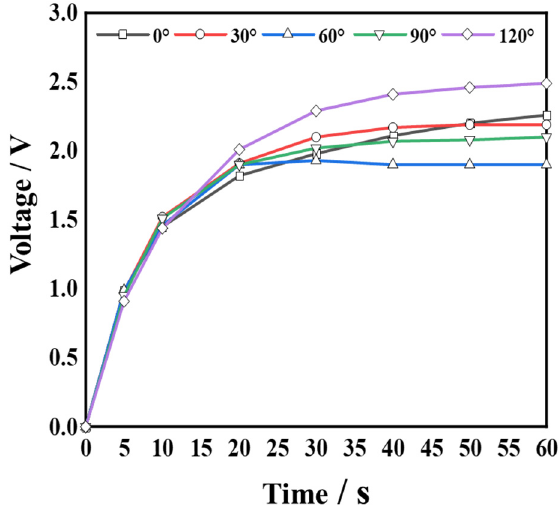
Figure 16. The effect of charging the capacitor for 60 s at a frequency of 2.7 Hz, a = 0.03 g, H = 23 mm. Table 2. Performance comparison of the proposed PVEHs with the existing